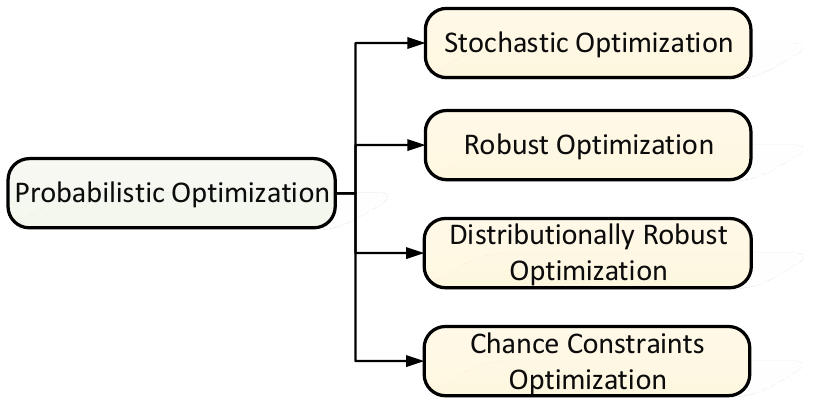
Figure 1. Classification of probabilistic